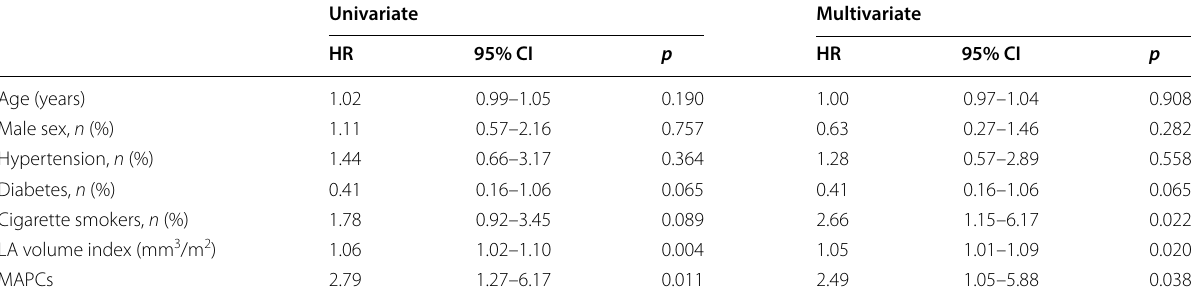
CI confidence interval, HR hazard ratio, LA left atrium, MAPCs multiple atrial premature contractions